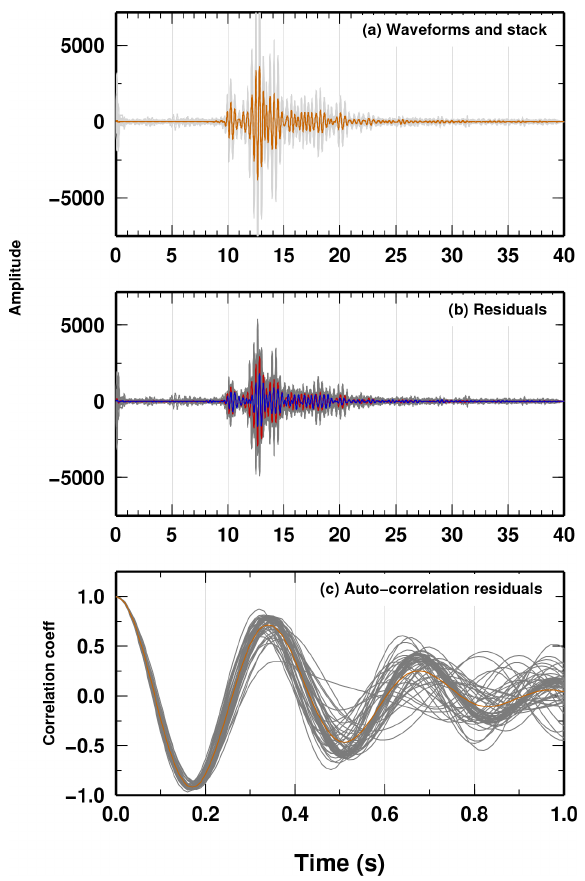
Figure B2. (a) Original waveforms w i (t) (grey lines) and their stack, called “beam waveform” b(t) (orange line). (b) Residual of each single waveform r i (t) (grey lines) with respect to the beam waveform. As a reference, the residual for the first (last) trace is shown as a blue (red) line. (c) Autocorrelation of the single residu- als (grey line) and averaged value of the autocorrelation c(t) (orange